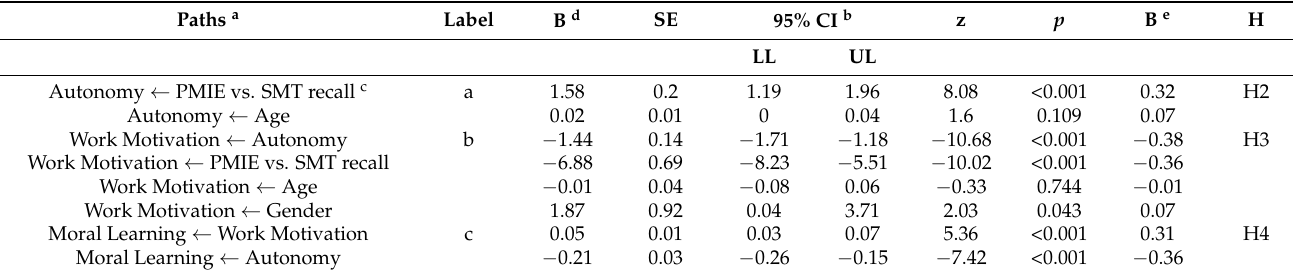
Table 5. Path analysis parameter